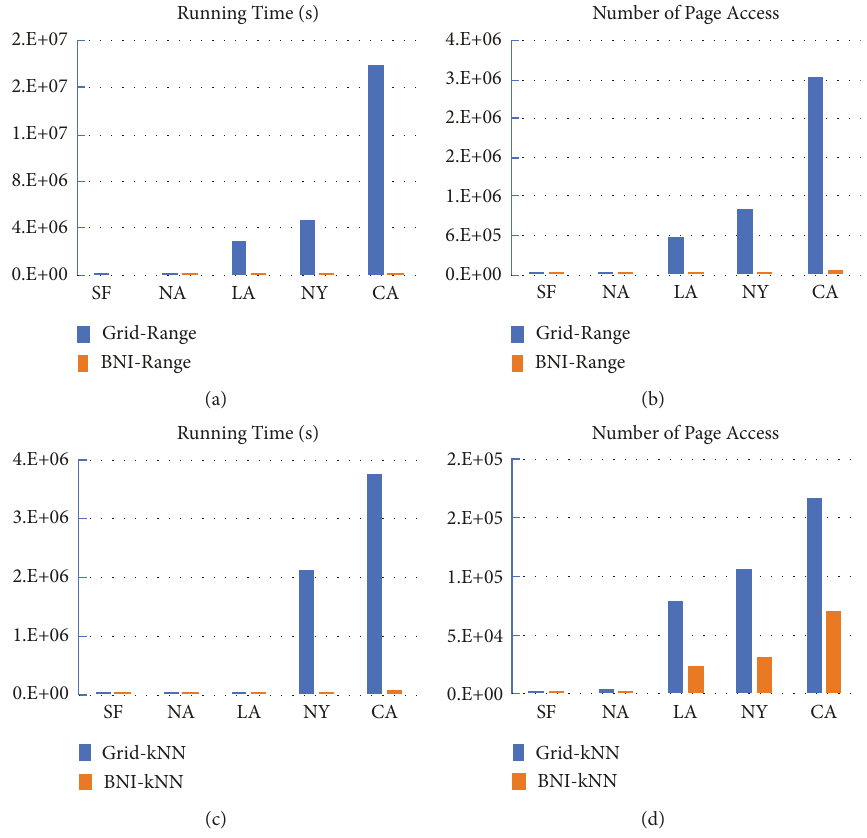
Figure 12: Overall performance on different data